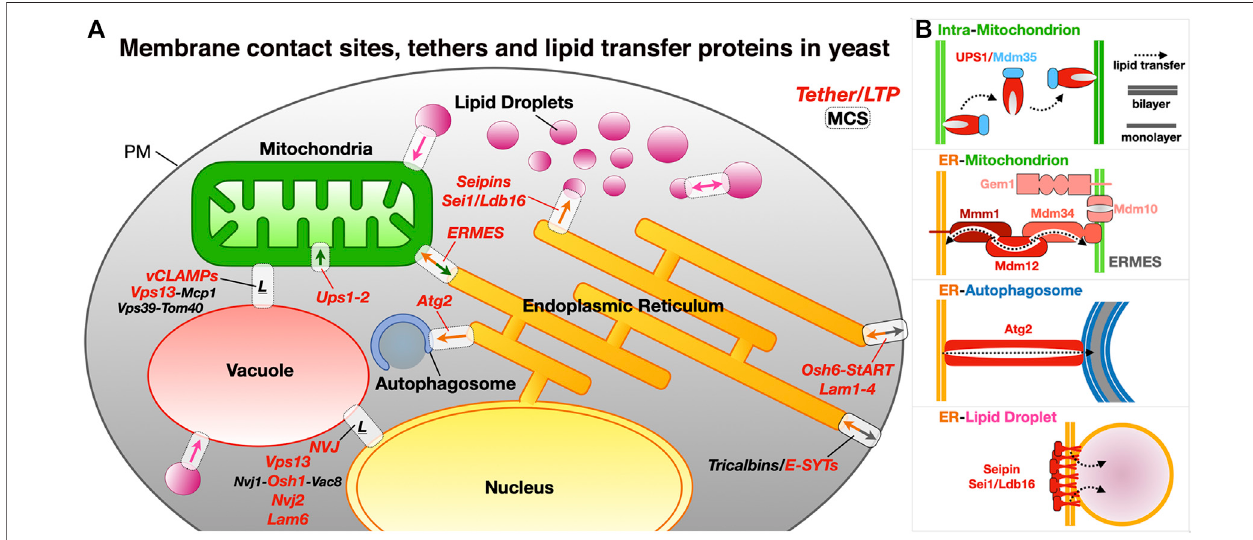
FIGURE1| Membranecontactsitesandtheirassociatedproteinaceoustethersinyeast. (A) SchematicofayeastcellshowingsomeoftheMCSsexistingbetween diverse organelles together with some of the identi fi ed proteinaceous tethers mediating juxtaposition of their membranes. ER, endoplasmic reticulum; PM, plasma membrane; LD, lipid droplets; ERMES, ER-mitochondrion encounter structure; vCLAMP, vacuole and mitochondria patch; NVJ, nuclear ER-vacuole junctions. Ups/ Mdm35, at the inner mitochondrial membrane space interface (IMMSI); Atg2 at the ER-to-autophagosome contact site; Vps13 at vCLAMP and NVJ. Lam6, NVJ protein2andNVJprotein1associatedtoVac8andOsh1atNVJ;SeipinsatER-LDcontactsites(yeastandMetazoans);Tricalbins/E-SYTs(yeast/Metazoans)atER-PM contact sites. Colored arrows indicate directionality of lipid exchange. (B) Schematic organization of some of the tethers/LTPs at the MCSs described as examples.